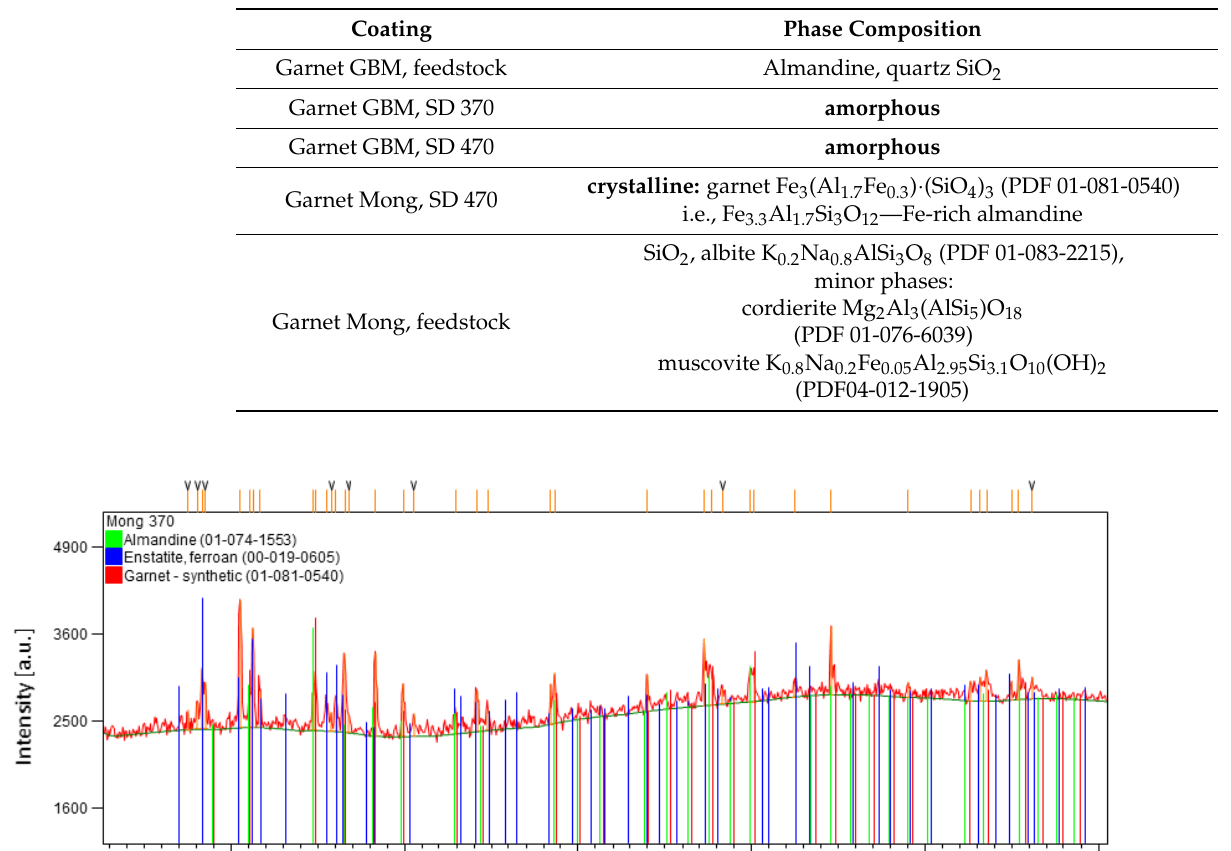
Table 1. Phase composition based on XRD.